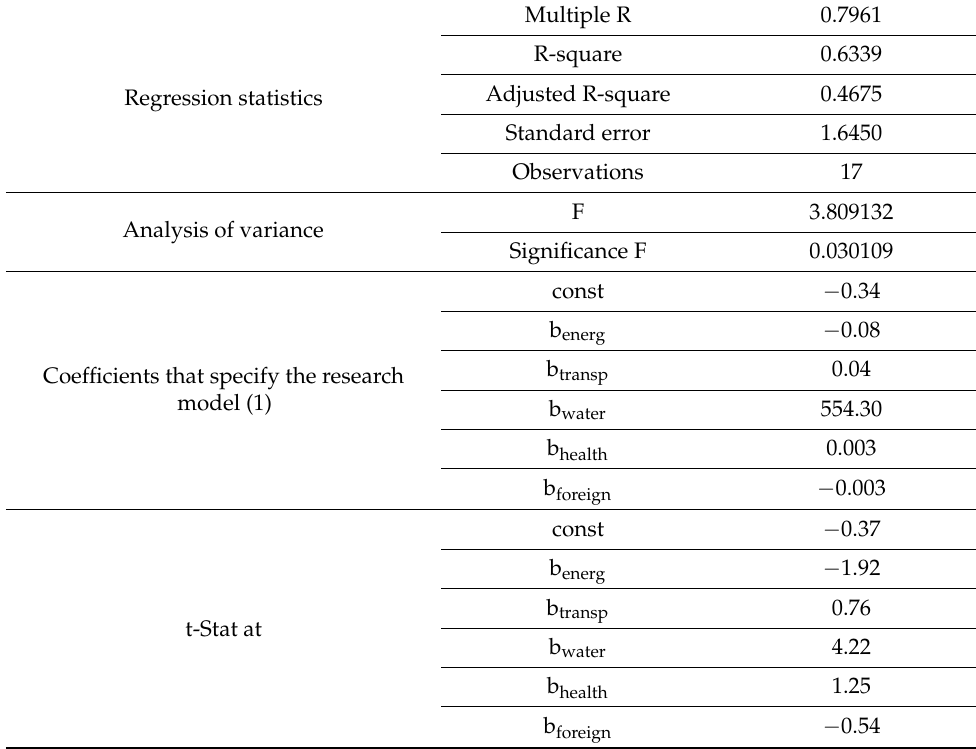
Table 5. Results of the regression